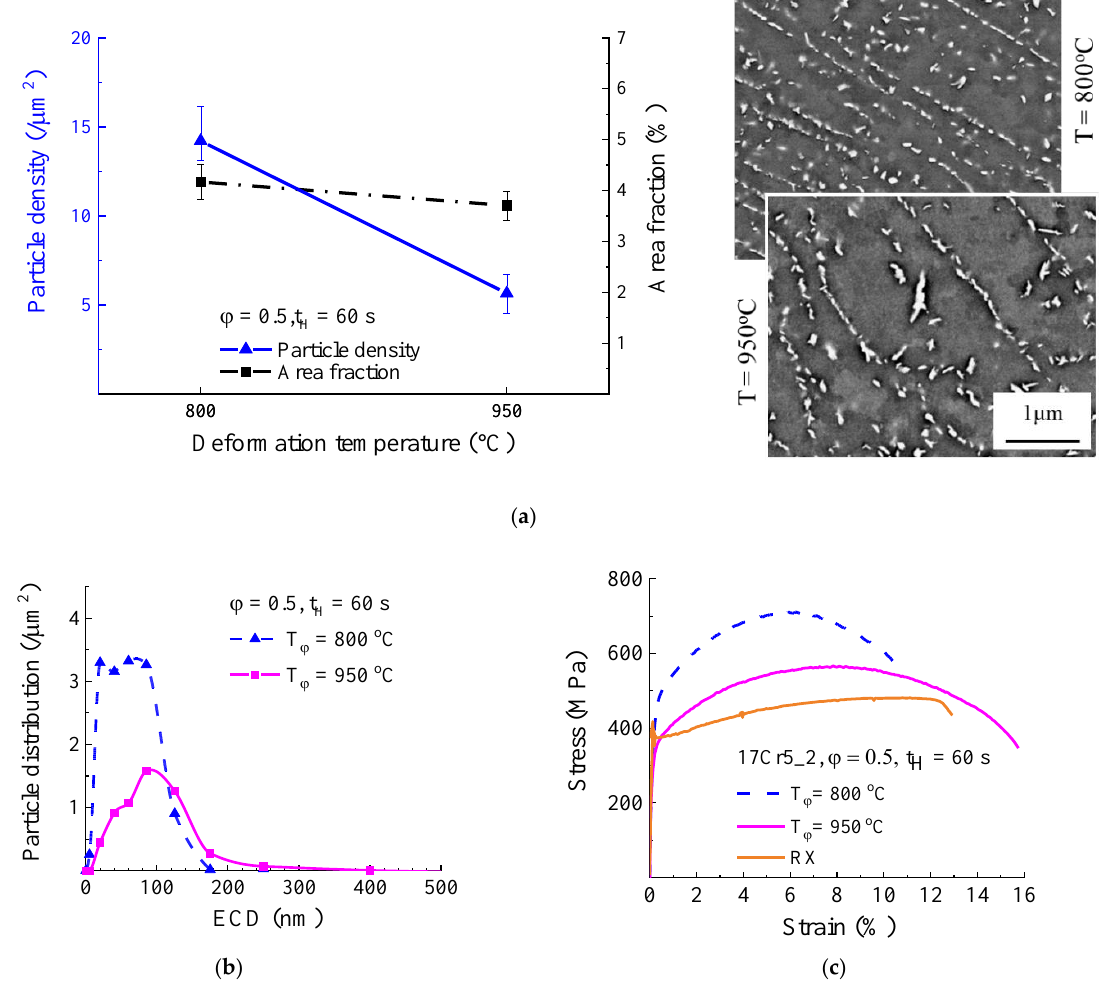
Figure 7. Impact of TMP temperature on ( a ) particle density and area fraction, ( b ) particle size distribution, and ( c) ambient-temperature tensile properties ( φ = 0.5, t H = 60 s, T = 800/950 °C).